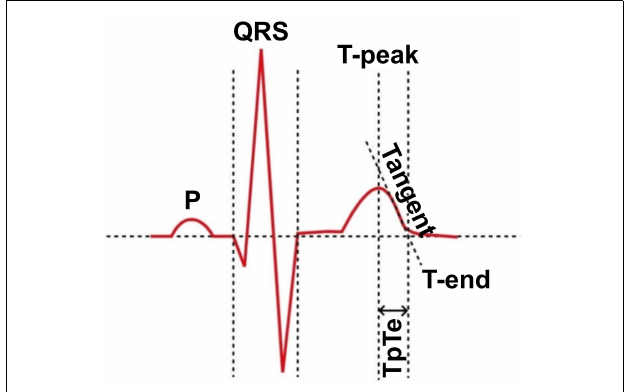
FIGURE 1 | The Tangent method of TpTe measurement, adopted from Yılmaz